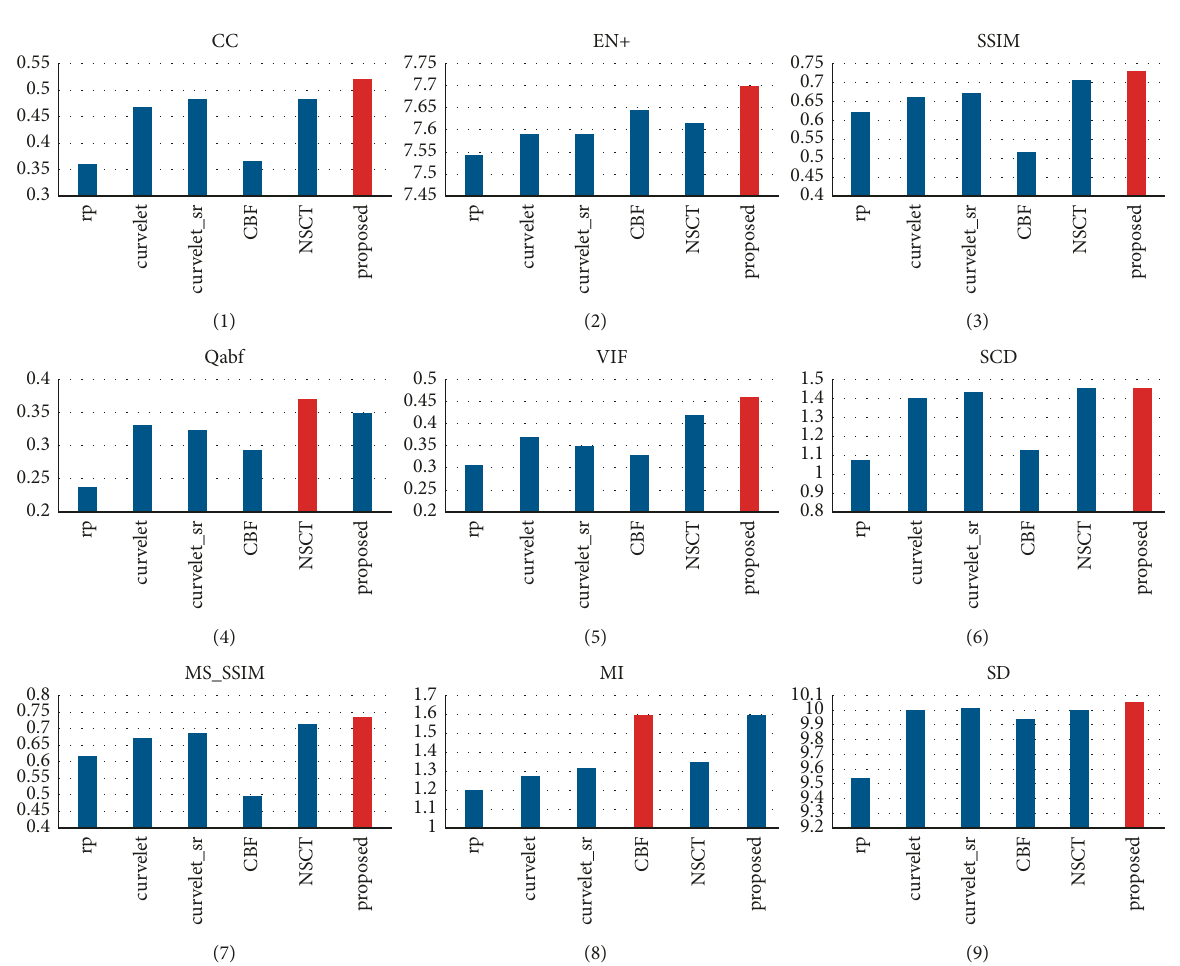
Figure 6: Comparison of the fusion results from different methods on the source images.